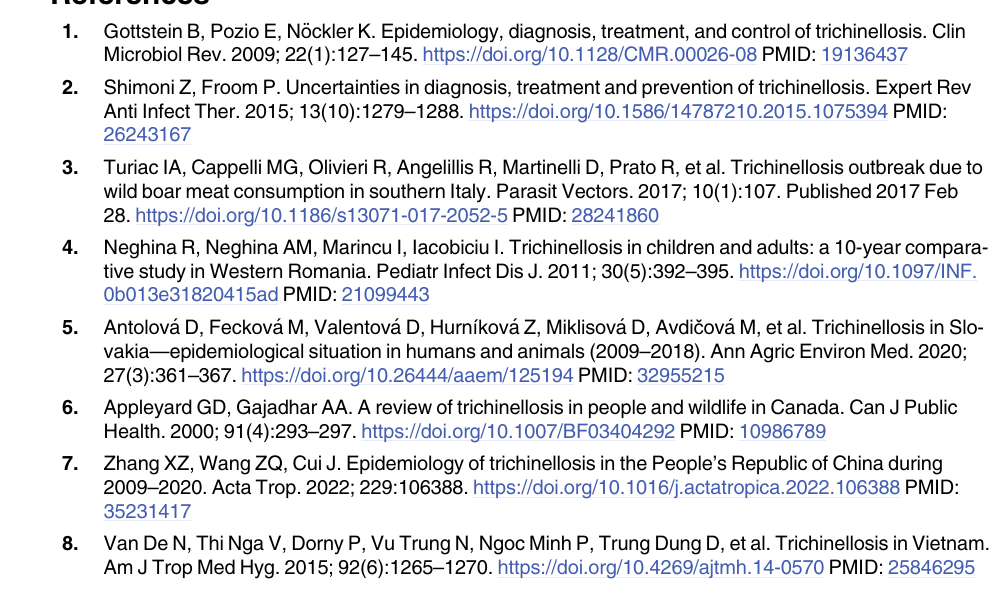
S6 Table. Potential glycerophospholipid markers those were not identified from human and mouse